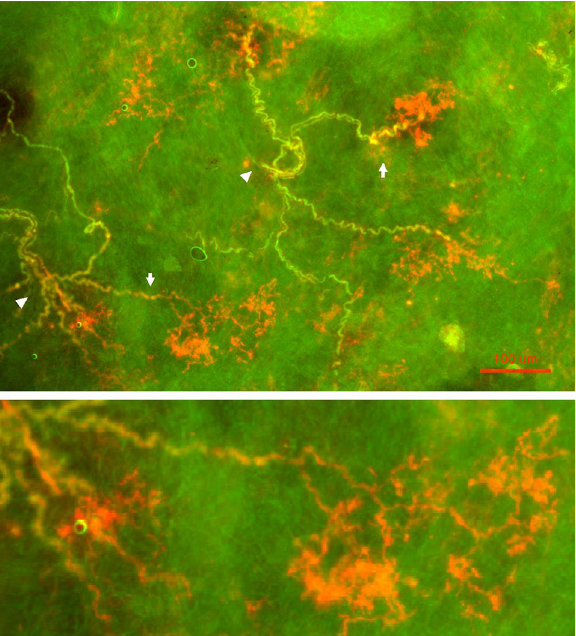
Figure 5. Another example for 2 types of morphology. Two white arrows indicate a diffuse type (left lower) and a compact type (right upper), respectively. Two white arrowheads indicate many axons from different receptors converge. The bottom part is the enlargement of the diffuse type. The scale bar is 100 µm.